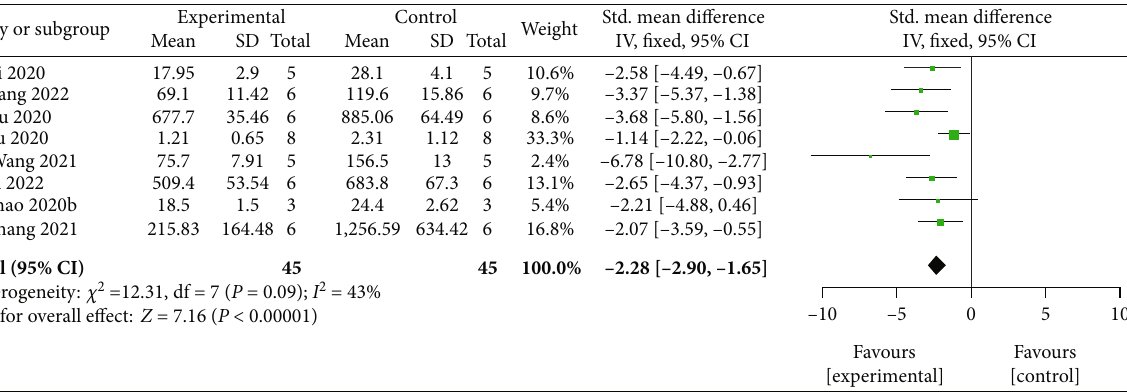
Figure 9: The forest plot: e ff ects of MSCs-derived sEVs for reduced the expression of proin fl ammatory factor IL-6 compared with control